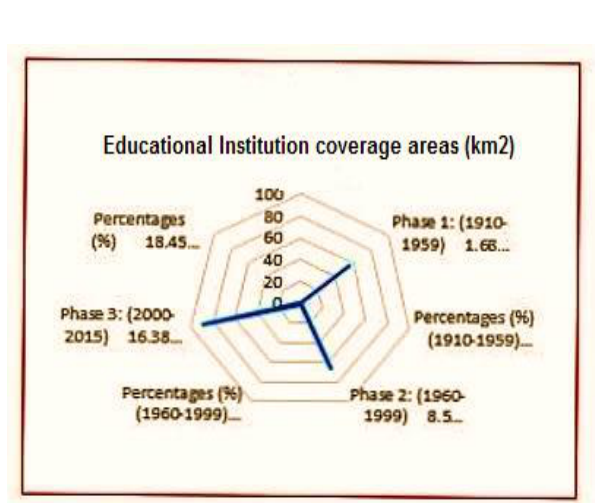
Figure 9. Total land use coverage (%)